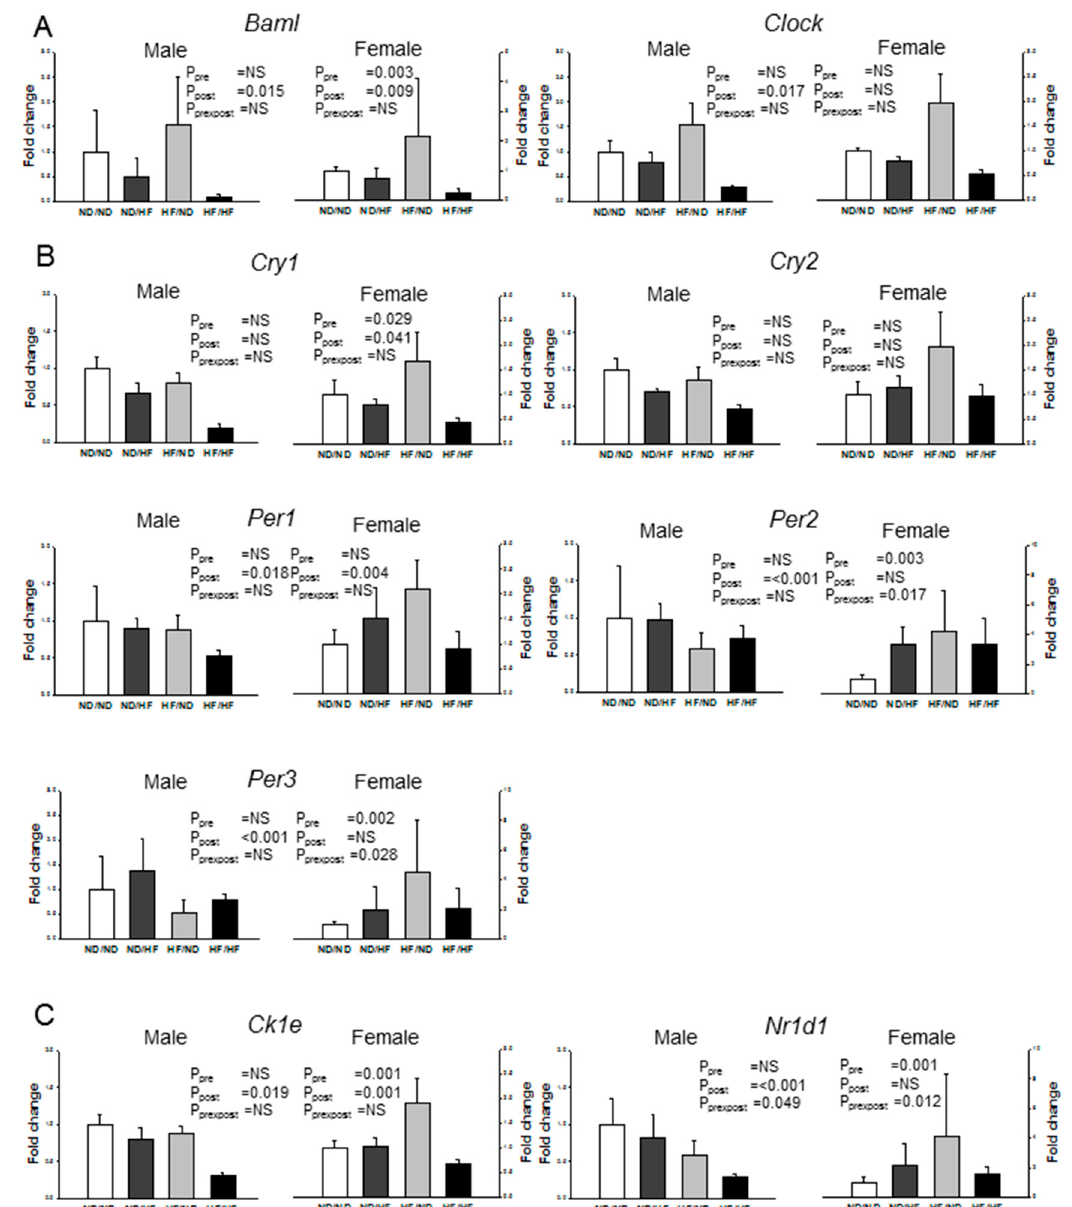
Figure 7. Effects of maternal and postnatal high-fat diet (HF) on mRNA levels of clock genes in male and female offspring kidneys. Relative fold changes of: ( A ) positive element Baml and Clock ; ( B ) negative elements Cry1, Per2 , and Per3 ; and ( C ) clock-controlled gene Ck1e and Nr1d1 as quantified. Pre × Post, interaction of pre × post; NS, not significant; N (pups/L) = 5-7/3 per group.